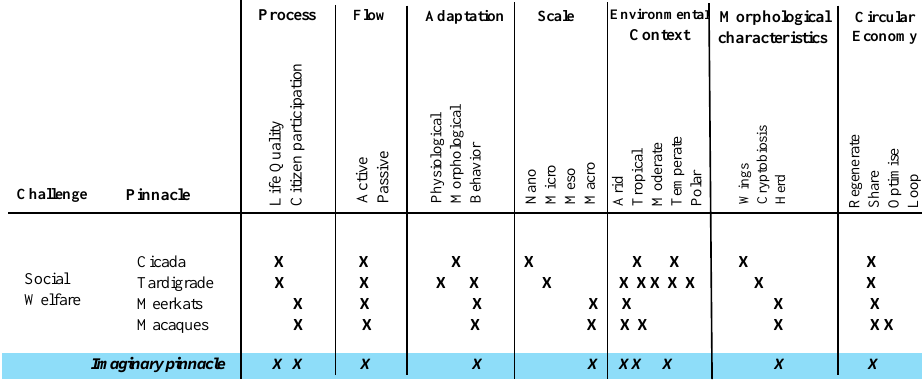
Figure 7. Pinnacle matrix analysis for the social welfare